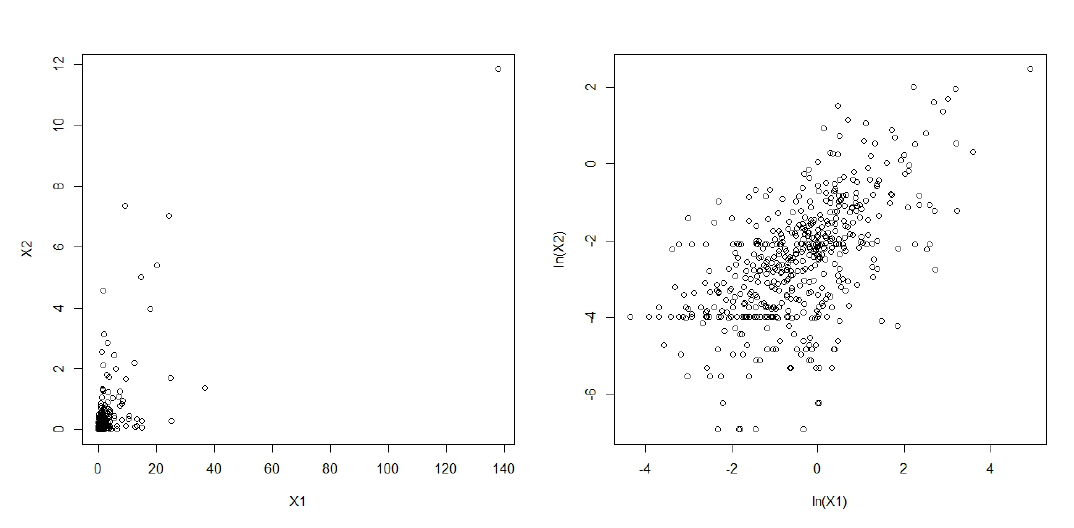
Figure 4. Scatterplots of X 1 vs. X 2 in original ( left ) and natural ( right ) logarithm scales.